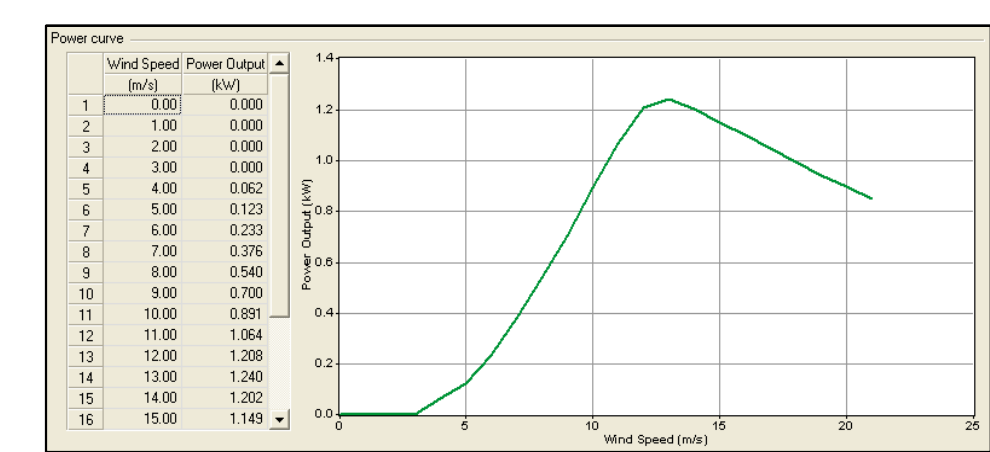
Figure 11. The output power over a different wind speed values.